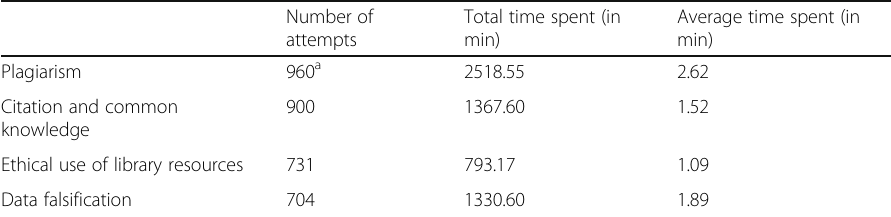
Table 3 Clickstream — time on tasks ( N =